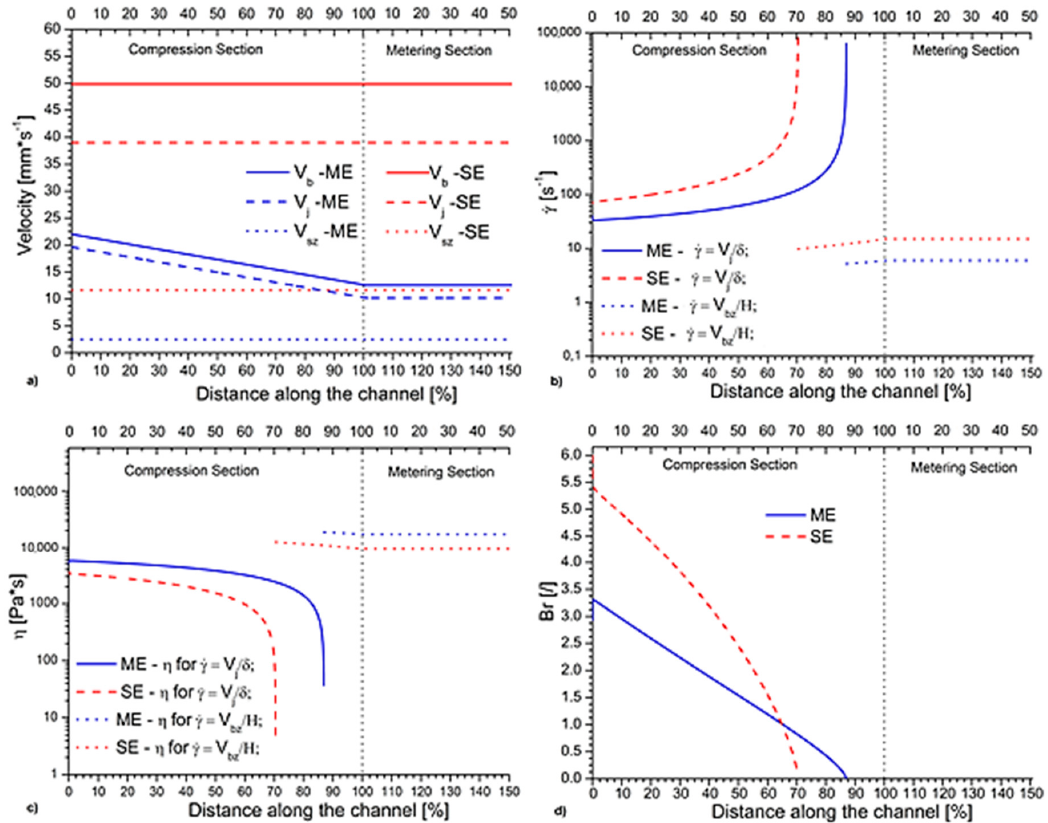
Figure 3. ( a ) Variation of velocities in compression and metering section for micro-extrusion (ME) case (blue full line, material properties, dimensions and settings from Table 1, Column 2 and conventional / standard extrusion (SE) case with same screw speed and barrel temperature (red dashed line, material properties, dimensions and settings from Table 1, Column 3; ( b ) corresponding variation of shear rates that are in the compression section defined based on the relative velocity and the melt layer thickness and in the metering section (strictly as soon as the melting is done) based on the total channel height and the drag flow definition; ( c ) the associated variation of viscosity; and ( d ) the associated variation of the Brinkman